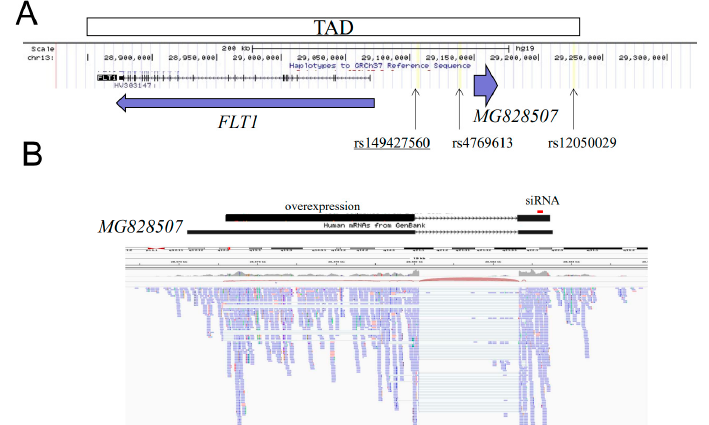
Figure 1. Genomic structure of the FLT1 upstream region. ( A ) Location of the MG828507 and FLT1 genes. The horizontal arrows indicate their transcription direction. The extent of the TAD that incorporates these genes is indicated by the large box. The vertical arrows indicate the location of the three variants tested in this study. The STR, s149427560, is underlined. ( B ) RNA-seq of MG828507 . The horizontal bar indicates the MG828507 gene registered in the public database with its exon-intron structure. The upper panel indicates the position of the cDNA for overexpression experiments as well as the position targeted by the siRNA oligonucleotide used in this study.